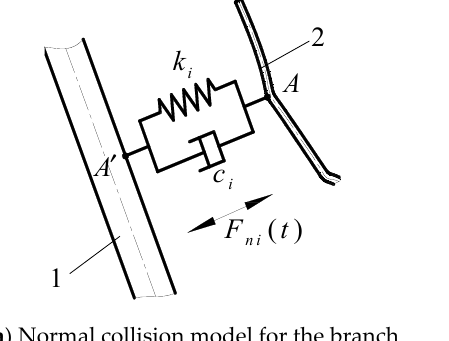
deformation diagram of the branch Figure 5. Nonlinear elastic damping model for the normal collision force in blueberry harvesting. Note: δ ni ( t ) is the normal deformation of the blueberry branch at the point of collision ( µ m ) . 1. Finger rows 2. Blueberry branch.